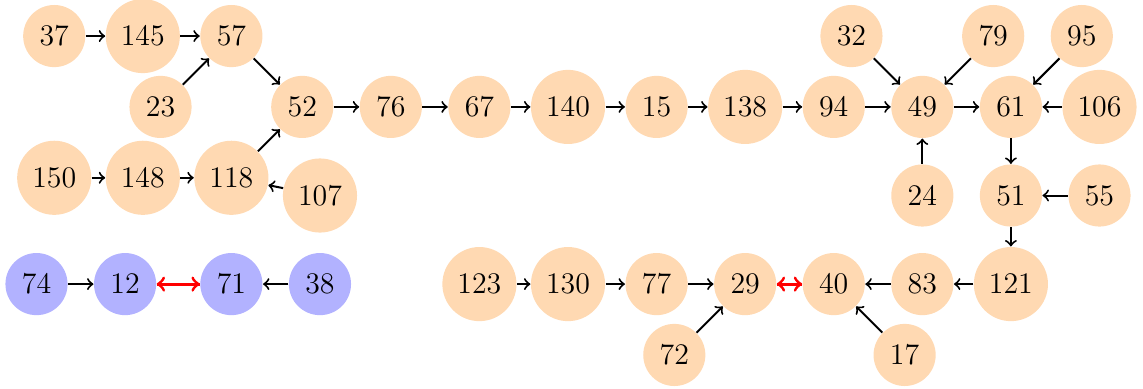
Figure 6: 2 components containing cycles of length 2